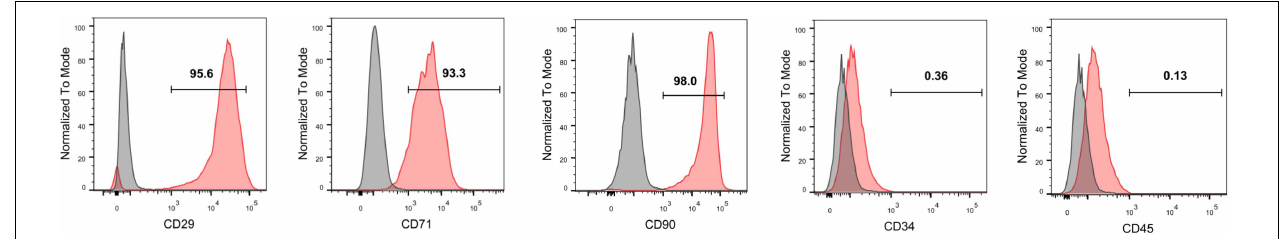
FIGURE 1 | Identification of rat MSCs by flow cytometry. The MSCs were positive for the surface antigens CD73, CD29, and CD90 and negative for CD45 and CD34.